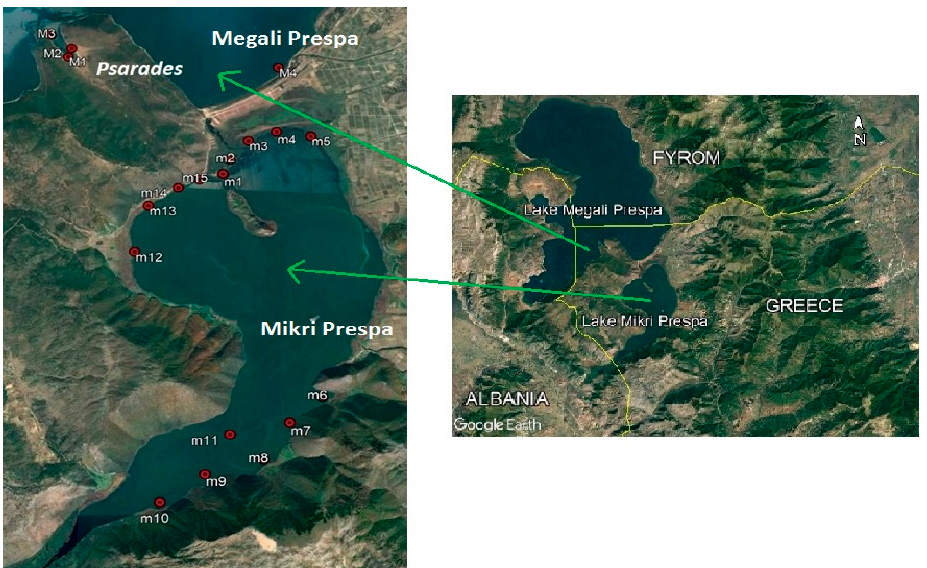
Figure 1. Map of the studied transboundary Lakes Megali and Mikri Prespa in northwestern Greece, with the sampling sites marked in red.